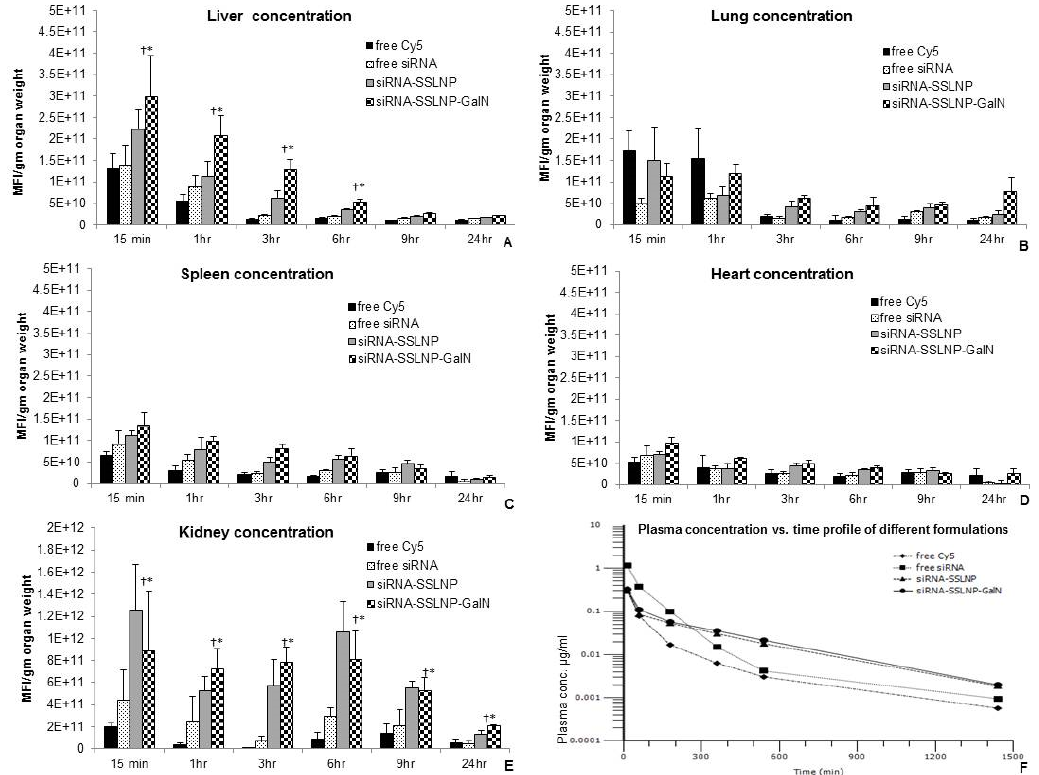
Figure 7. Biodistribution of different siRNA formulations compared to free Cy5 fluorophore over 24 h periods in ( A ) liver; ( B ) lung; ( C ) spleen; ( D ) heart; and ( E ) kidneys. Targeted formulation (siRNA-SSLNP-GalN) shows significant concentrations in liver and kidneys over observation period ( n = 4 for each time point; * p < 0.05 vs. free siRNA treated animals, † p < 0.05 vs. free Cy5 treated animals); ( F ) Plasma concentration vs. time after single intravenous administration of various Cy-5 labeled formulations in Balb/c mice. (Data are presented as mean ± SD; n = 4 animals/each time point, MFI-Mean fluorescence intensity).